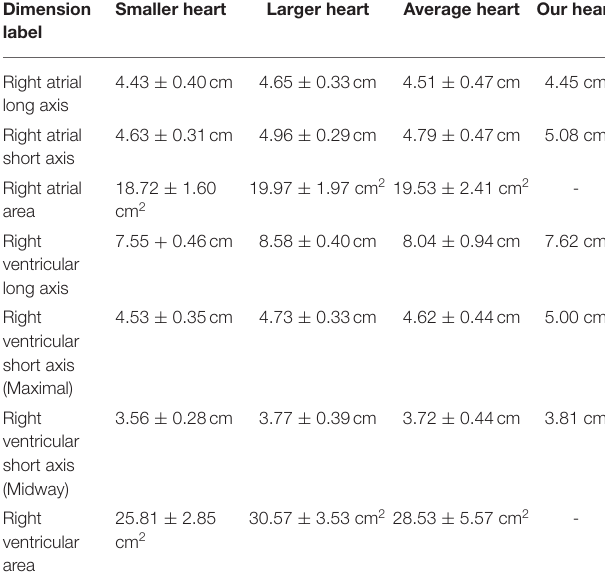
TABLE 2 | The dimension of the heart